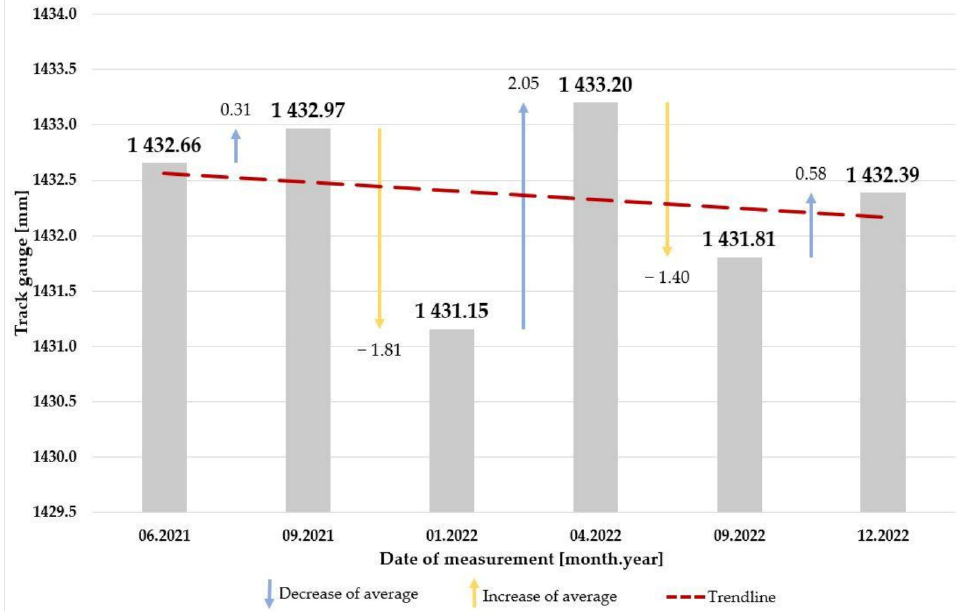
Figure 14. The change of average values of the track gauge in Section #3. Figure 15 represents the examination of the change of alignment and longitudinal level parameters. The trendline of the longitudinal level—similar to Section #1 and Section #2—is evidently increasing. On the other hand, the trendline of the alignment parameter shows a decrease.